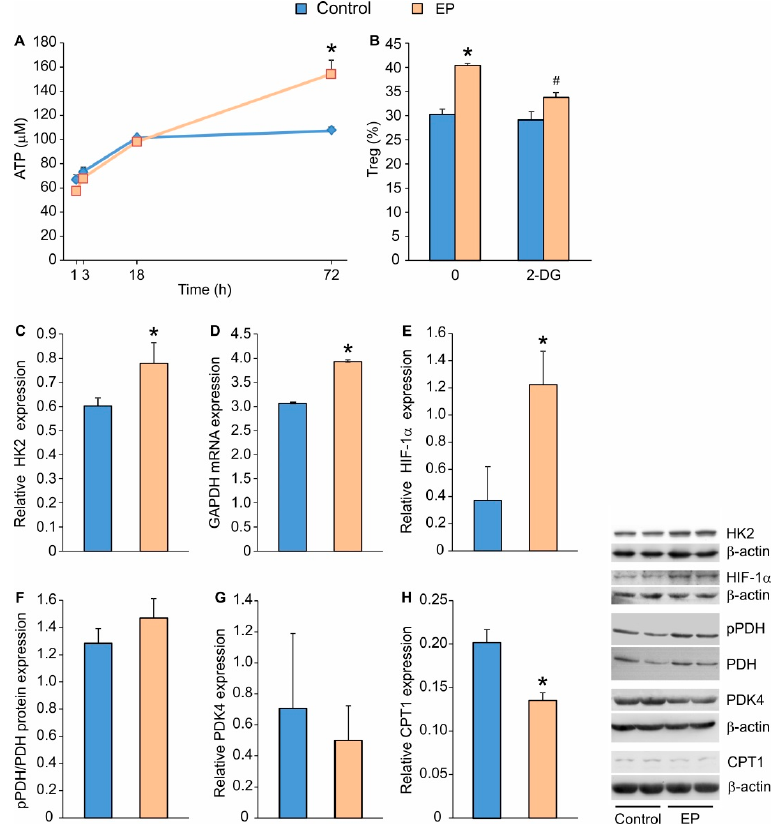
Figure 2. The influence of EP on metabolic pathways in differentiating Treg. ( A ) ATP cell content measured by chemiluminescence method in cells first exposed to a conventional Treg differentiating cocktail for 24 h and after EP treatment, at indicated time points. ( B ) The effect of 2-deoxyglucose (2-DG) on Treg (CD4 + CD25 high FoxP3 + ) proportion in control cells or EP-treated cells, measured 72 h after 2-DG addition. Relative protein expression (compared to β -actin or the total protein form) measured by immunoblot 72 h after EP administration: ( C ) HK2, ( E ) HIF-1 α , ( F ) phosphorylated PDH (pPDH), ( G ) PDK4 and ( H ) CPT1. ( D ) Relative GAPDH mRNA expression (compared to β -actin) measured 72 h after EP administration. Representative blots are shown on the right-hand side. * p < 0.05 represents the significant difference of EP-treated cells in comparison to control cells, while # p < 0.05 represents the significant difference between 2-DG+EP-treated cells in comparison to EP-treated cells.